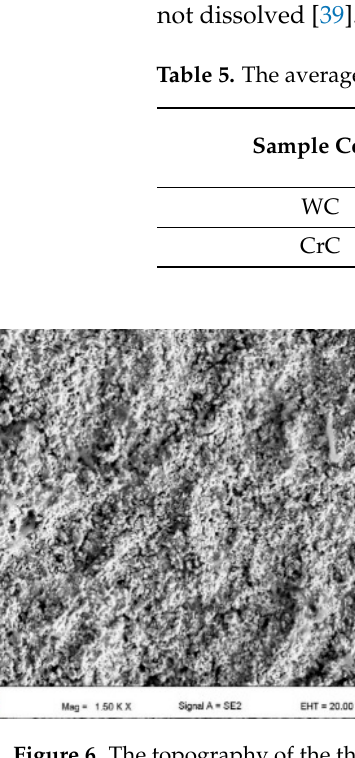
Figure 6. The topography of the thermally sprayed coating surface: ( a ) WC and ( b ) CrC (SEM).